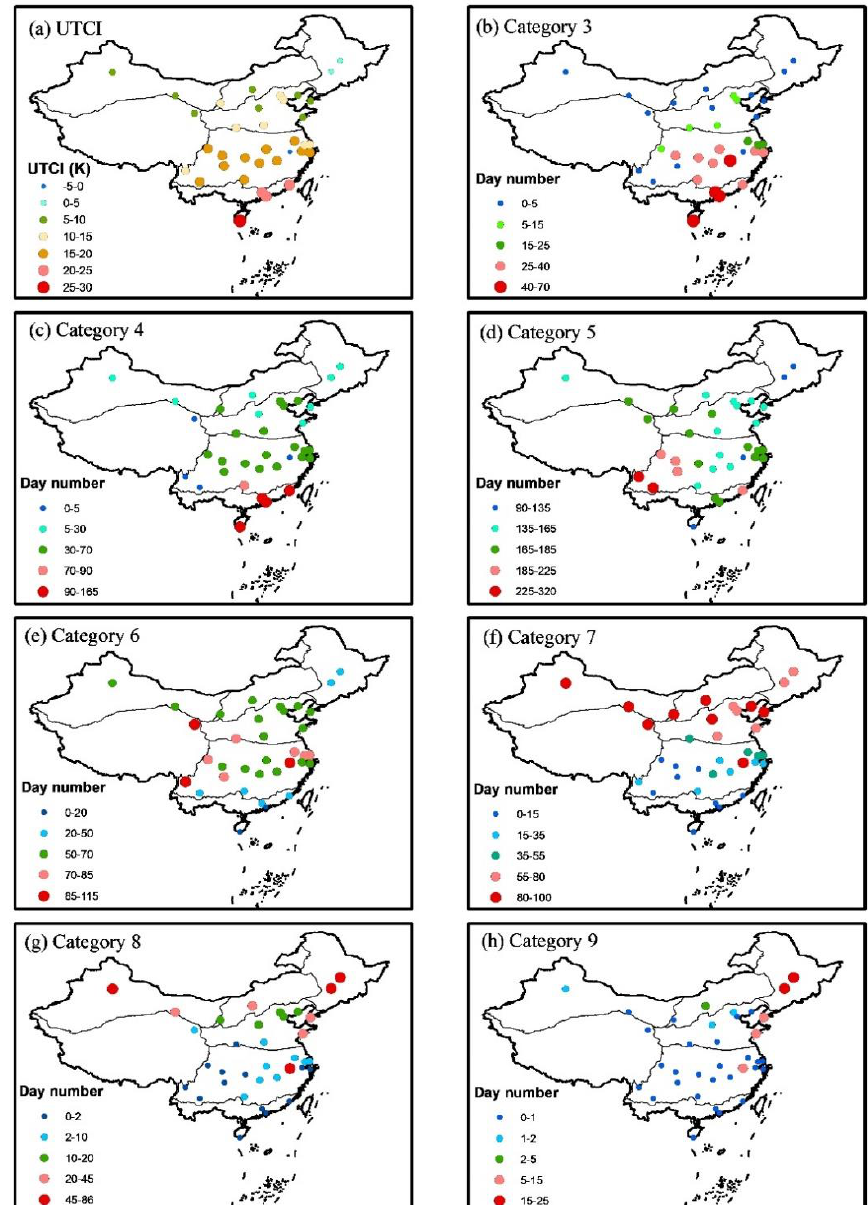
Figure 5. Spatial distribution of UTCI and yearly days within each category in the large tourism cities of China.